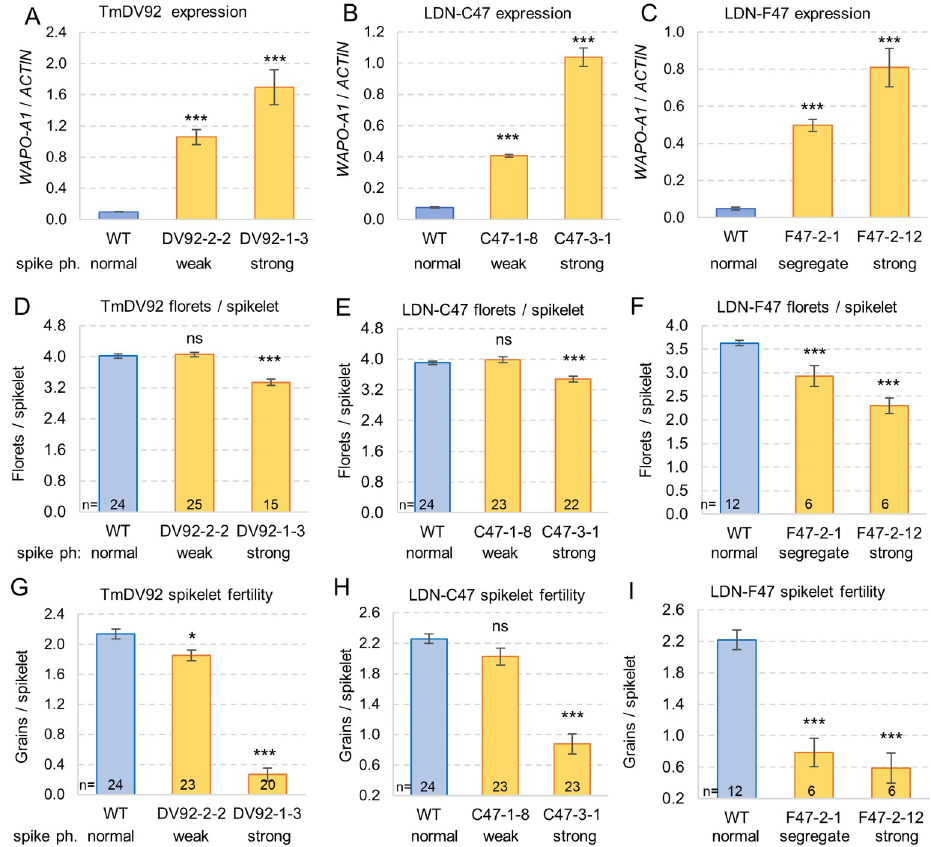
Fig 5. WAPO-A1 transcript levels and fertility in Kronos transgenic plants. ( A–C ) qRT-PCR transcript levels calculated with the Δ Ct method using ACTIN as an endogenous control. Bars are averages of four replications and each replication corresponds to a pool of 6–9 developing spikes at the floret primordia stage (W3.5). Spike ph. = spike phenotype, weak = differences in SNS, strong = naked pistils and small terminal spikelet, segregate = segregation for strong and weak spike phenotypes (F47-2-1). ( D–F ) Average floret number per spikelet ( G—I ) Spikelet fertility calculated as GNS / SNS. Only one spike per plant was measured. Kronos plants transformed with ( A, D and G ) TmDV92 (from T . monococcum ). ( B , E and H ) LDN-C47, and ( C , F and I ) LDN-F47. The first number in a transgenic plant designation corresponds to the transformation event. ns = not significant, � = P < 0.05, ��� = P < 0.001, indicate Dunnett test P value relative to the WT sister line. Bars represent averages and error bars are s.e.m. Numbers at the base of the bars indicate plants analyzed. Data and statistical analyses are available in Data E in S1 Data.